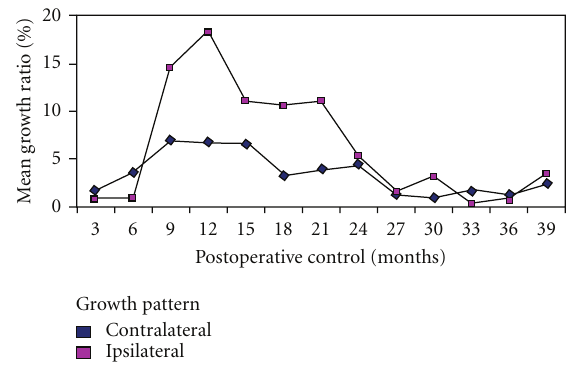
Figure 3: Percentage of growth change in ipsilateral and contralat- eral testes during control